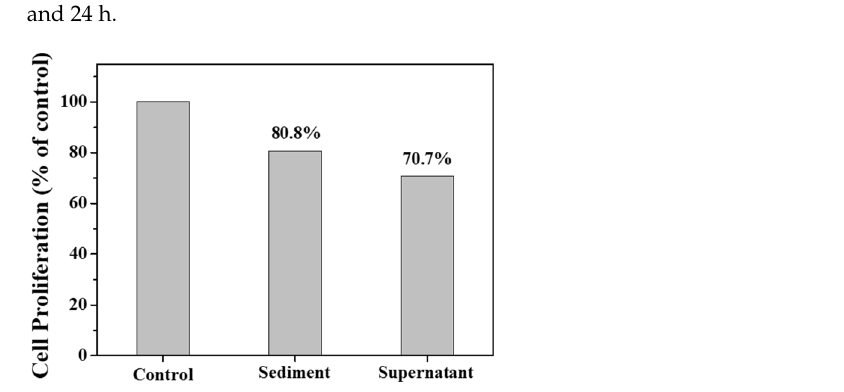
Figure 11. Cell proliferation assay result after 24 h of incubation with sediment and supernatant.